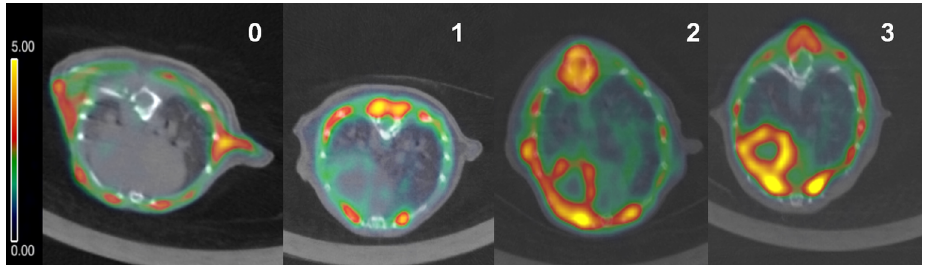
Figure 2. Four-grade visual uptake scale. 0, homogeneously minimal; 1 mostly minimal or mild; 2 mostly intense or moderate; 3 homogeneously